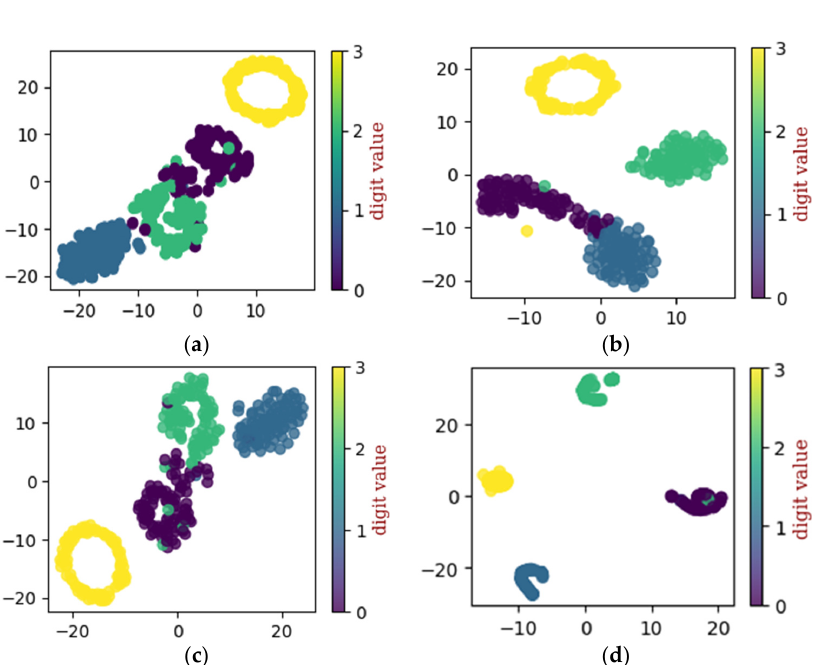
Figure 12. The t-SNE for self-learning ability utilizing dataset configuration B: ( a ) raw data, ( b ) con- volution layer, ( c ) convolution layer, and ( d ) final classification. volution layer, ( c ) convolution layer, and ( d ) final